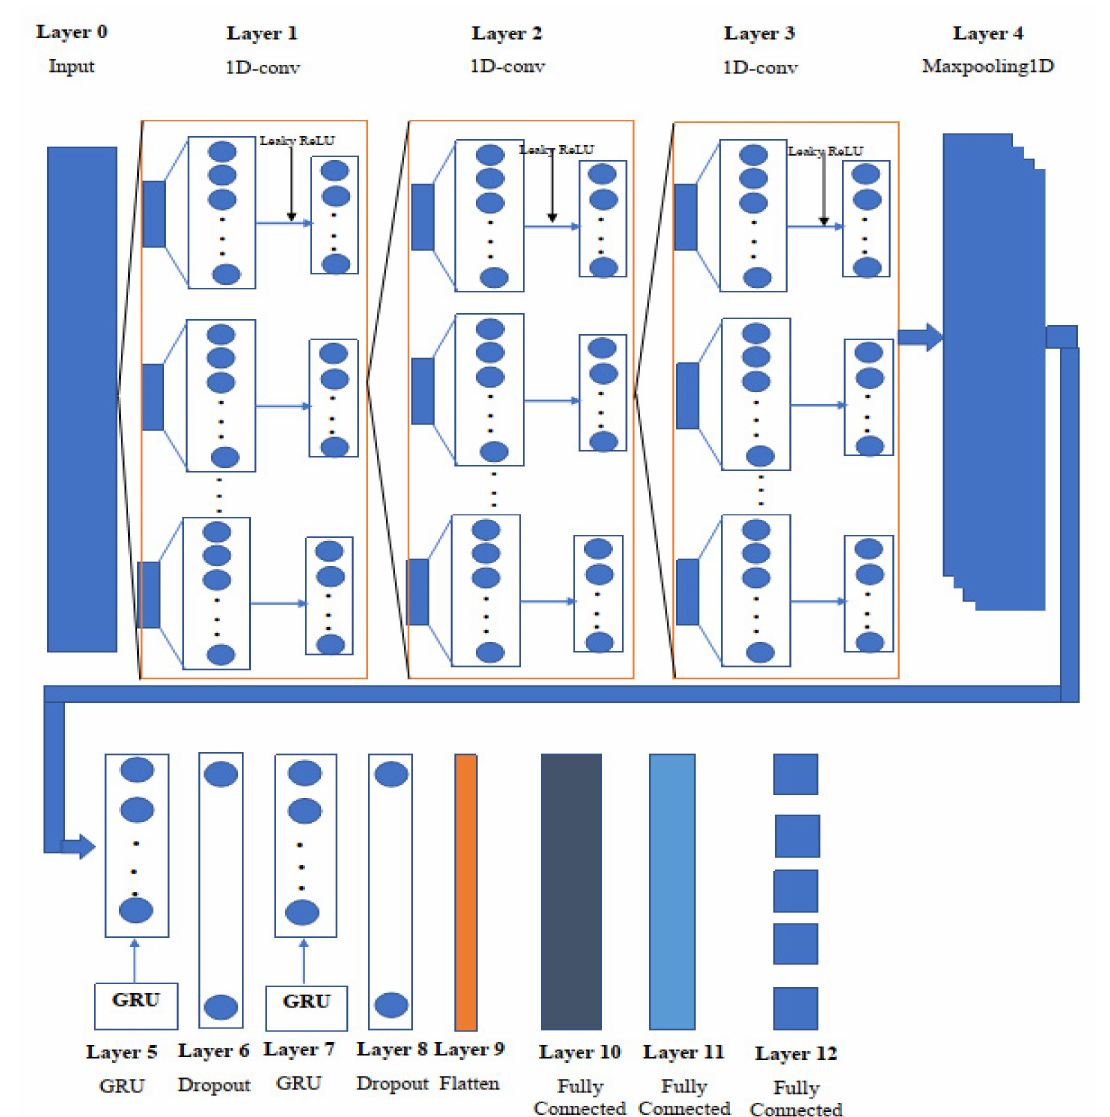
Figure 2. Schematic diagram of the one-dimensional convolutional gated recurrent neural